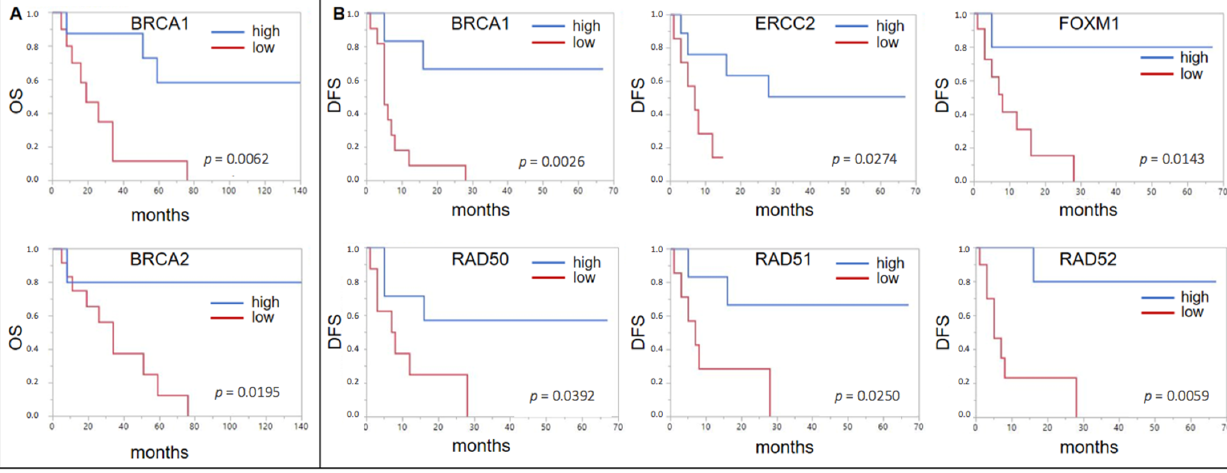
Figure 2. ( A ) Forrest plots of the correlation between RNA expression and overall survival (OS) in the Mannheim adjuvant cisplatin based chemotherapy (ACBC) cohort. ( B ) Forrest plots of the correlation between RNA expression and DFS in the Mannheim ACBC cohort.